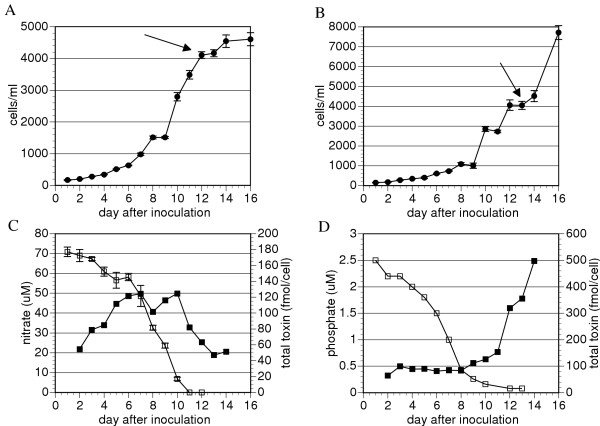
Growth, nutrient and toxin characteristics of nutrient-limited cultures. Cell densities were recorded daily in nitrate- (A) and phosphate- (B) limited cultures of A. fundyense. Arrows indicate the day that samples were collected for MPSS analysis. After harvest, the cultures were enriched with the limiting nutrient and changes in cell number were monitored. Nutrient concentrations (open symbols) and toxin per cell (closed symbols) were also monitored daily in the nitrate- (C) and phosphate- (D) limited cultures.